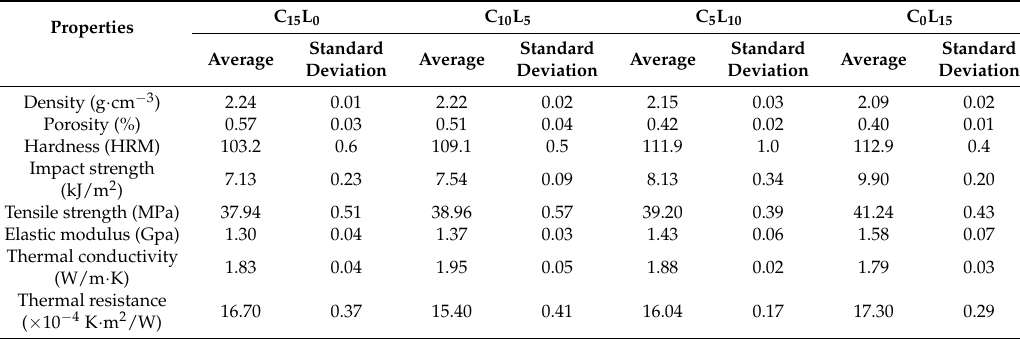
Table 7. Properties of the developed